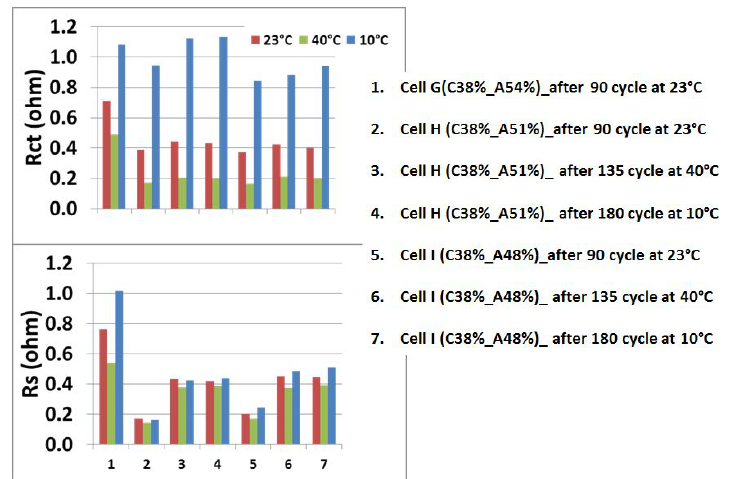
Figure 6. Comparison of the R s and R ct resistance values of the Li-ion full cells, containing electrodes with different porosities, after cycling at different